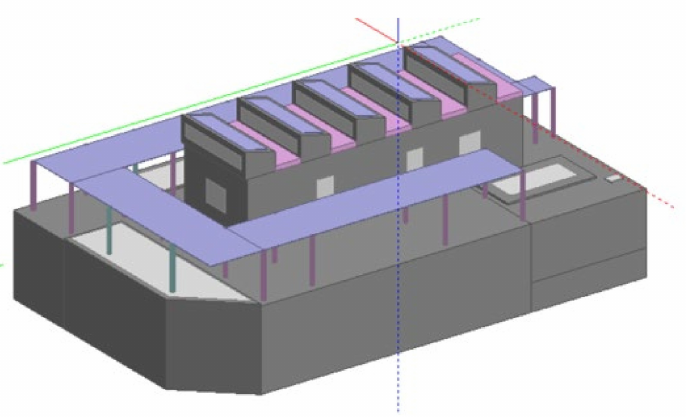
Figure 5. Architectural geometric